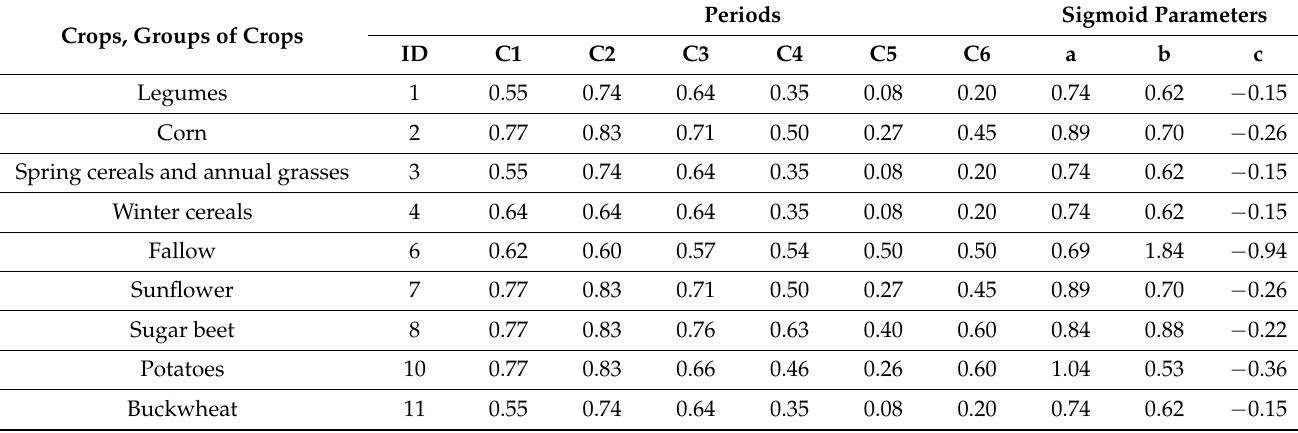
Table 3. Values of erosion indices of crops in periods of the warm part of the year 1 .